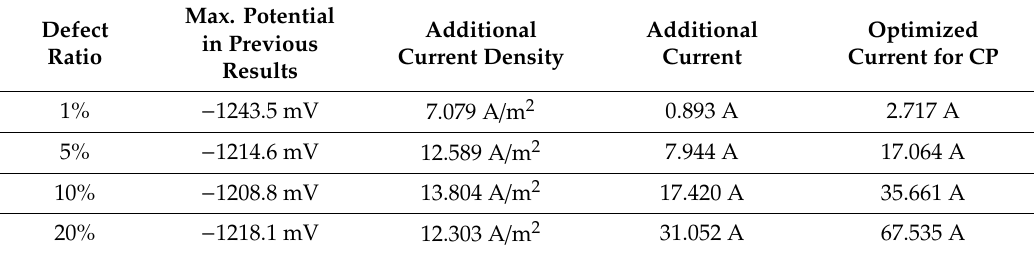
Table 7. Results of calculated additional CP current and optimized current for CP.